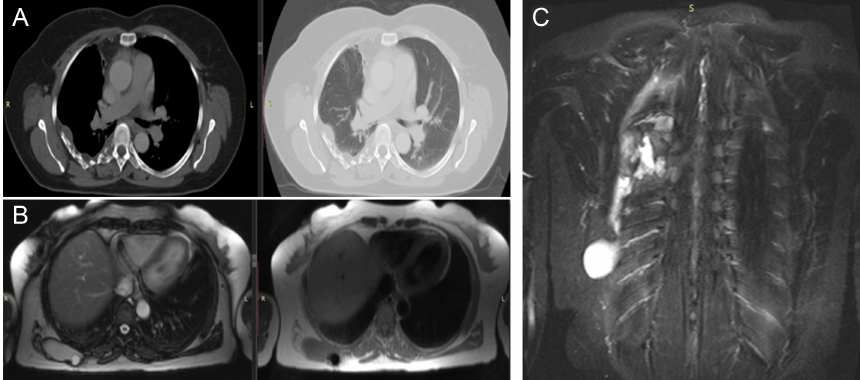
Figure 12. Contrast-enhanced computed tomography scan of the abdomen showing cystic lesions with a curvilinear laminated membrane at the tail of the